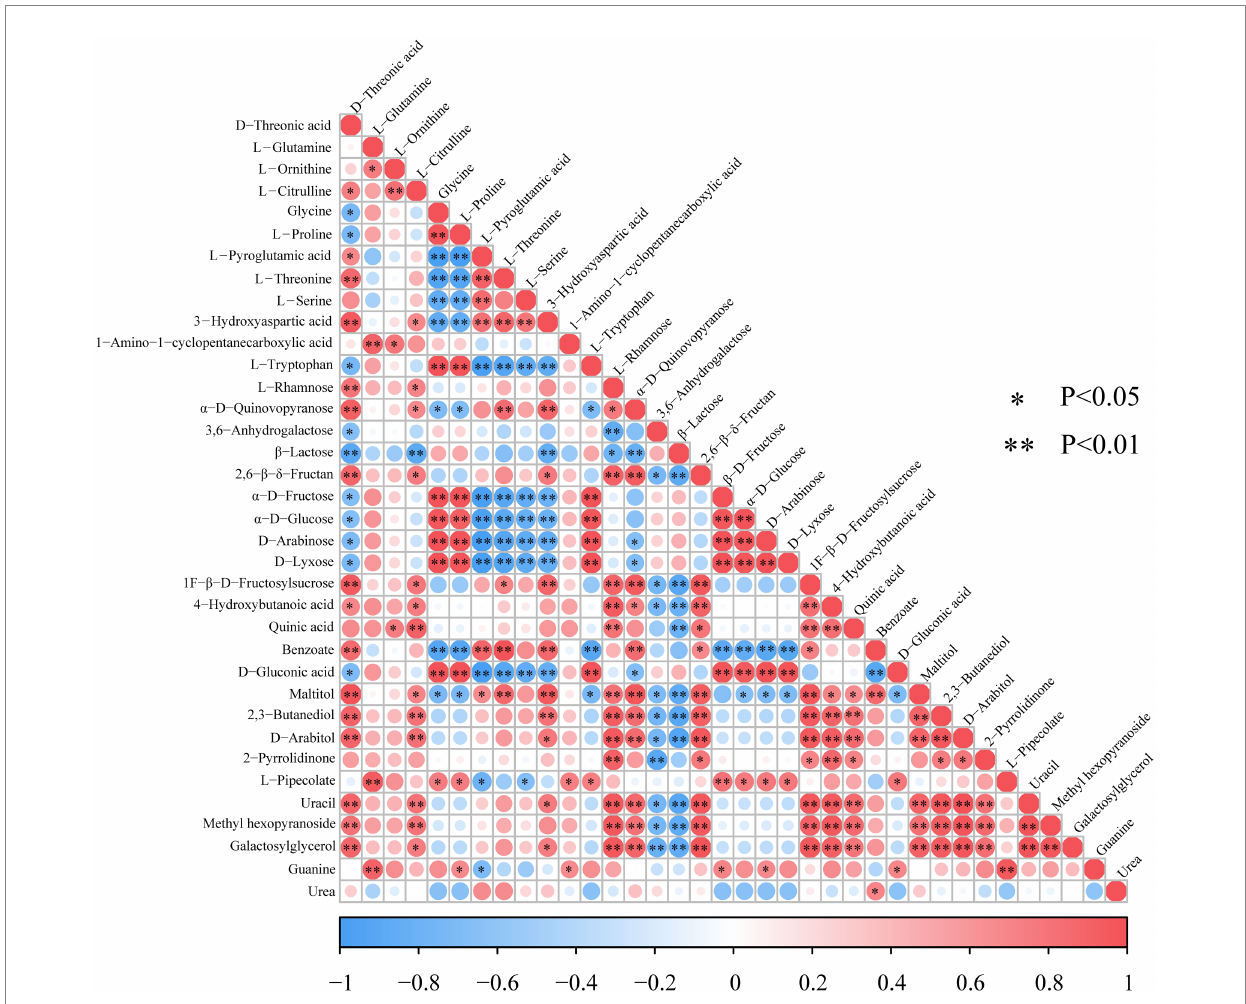
FIGURE 5 Heat map of differential metabolite correlations in LSCKs. Red and blue color, respectively, indicates a positive and negative correlation between the expression of the two metabolites. * and ** Indicates significant ( p < 0.05) and highly significant differences, respectively ( p <